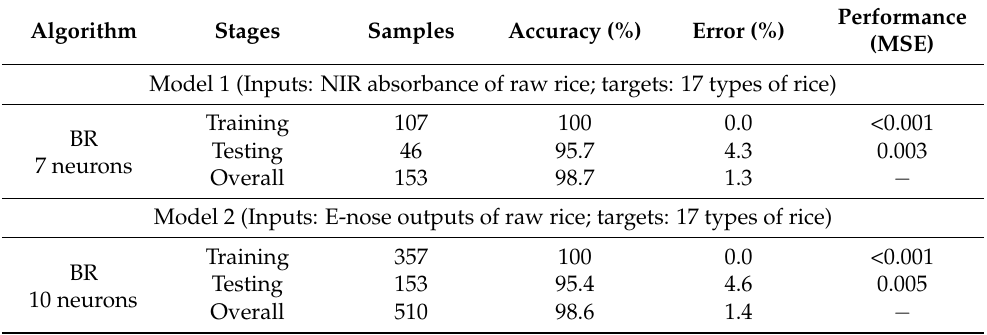
Table 3. Statistical results of Model 1 and Model 2 developed based on artificial neural network pattern recognition. Abbreviations: BR: Bayesian regularization; MSE: mean squared error; e-nose: electronic nose; NIR: